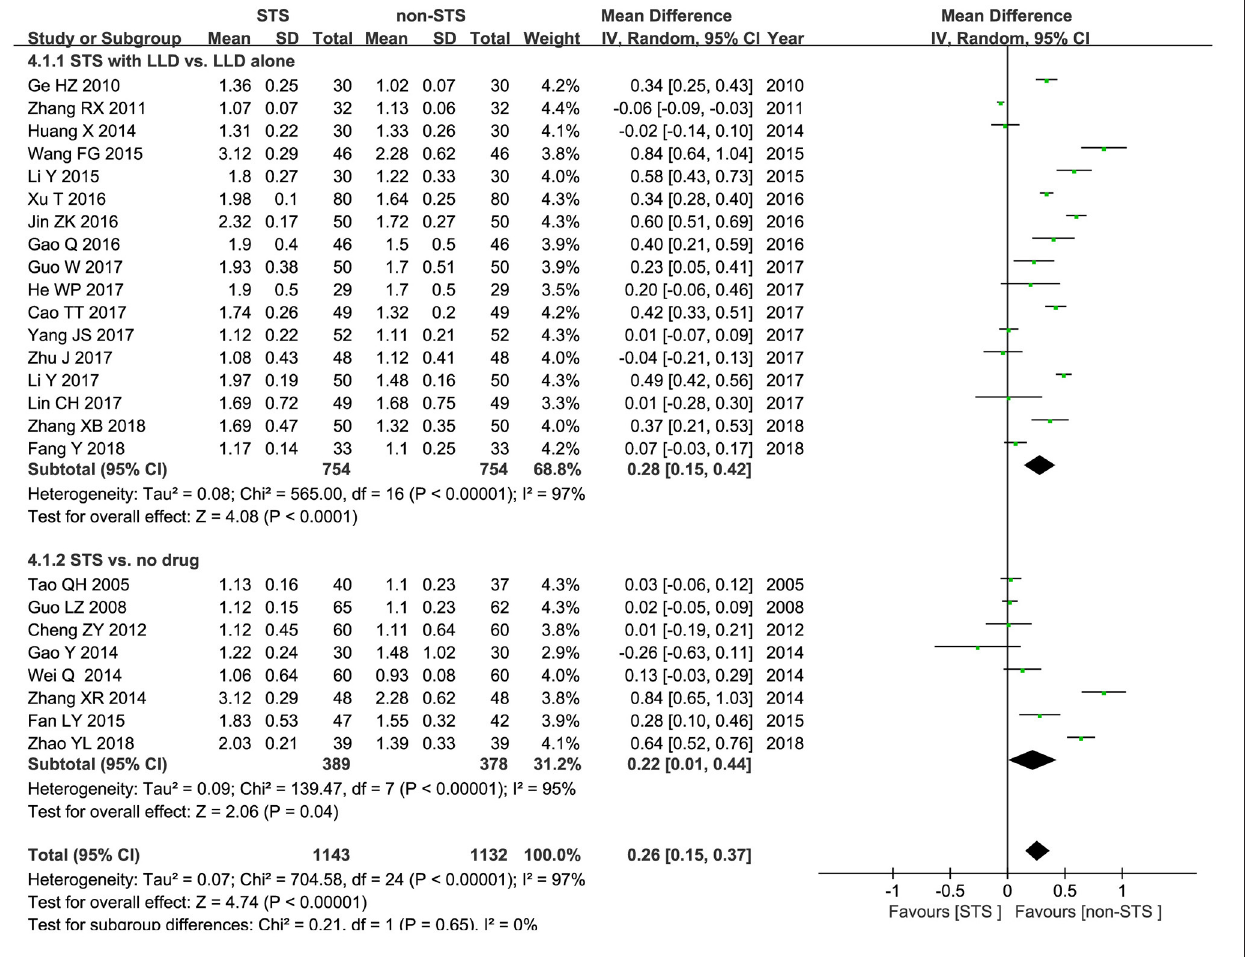
FIGURE 6 | Forest plot of comparison: STS vs. non-STS in